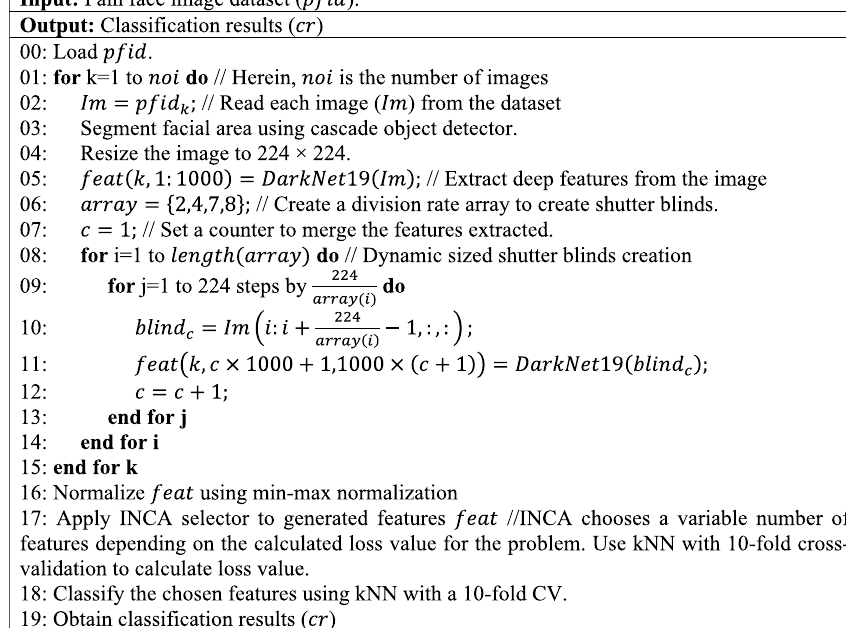
Algorithm 1 and are also explained below: Step 1: Divide the image into 21 dynamic-sized horizontal patches—“shutter blinds”—comprising